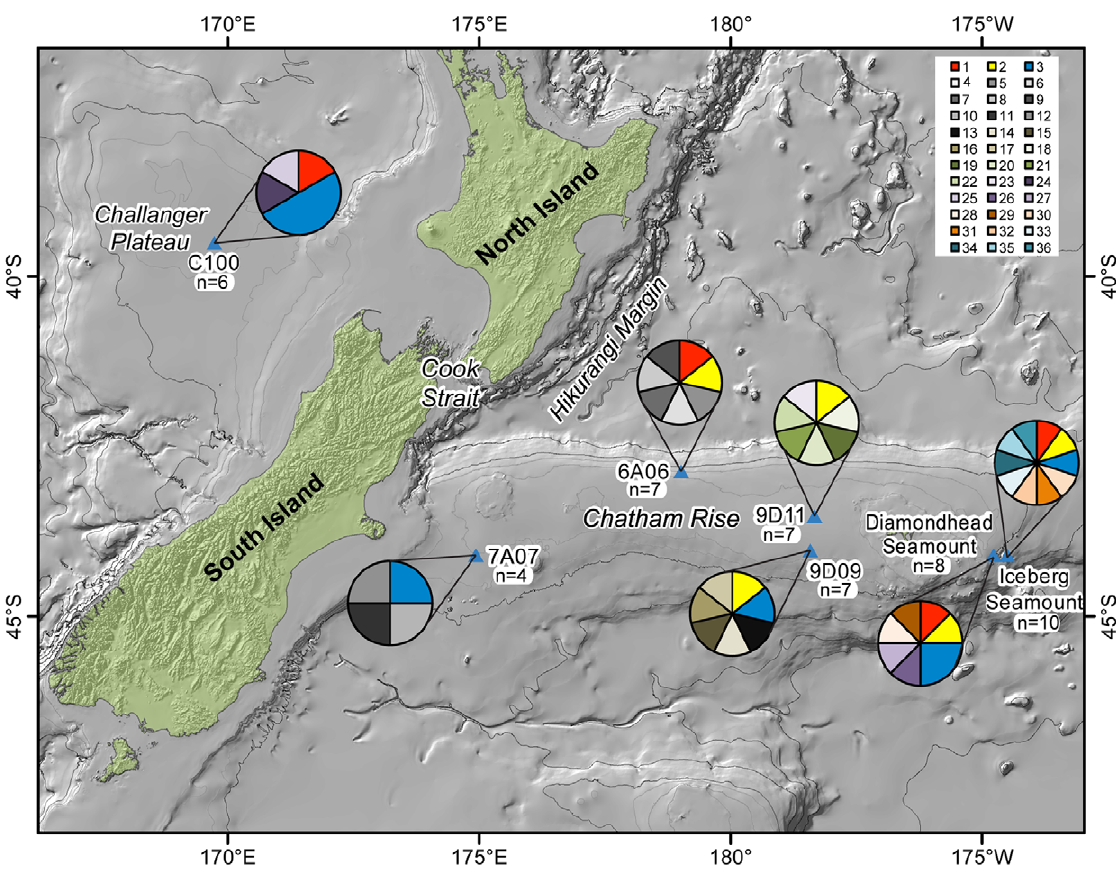
Figure 2. Distribution of COI haplotypes across the study area for Munidagracilis . The map shows the location of the study sites with pie charts indicating the haplotype composition of the population from that site. Each color represents a haplotype with Red, Blue, and Yellow representing the three shared haplotypes that are found across the study area. Shades of grey and other muted colors represent unique haplotypes. Sample size for each site is indicated.